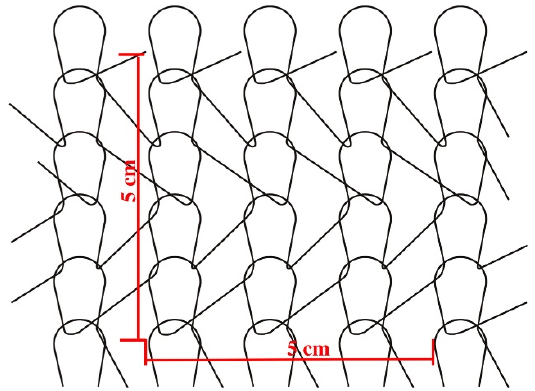
Figure 6. Diagram of stitch density measurement.